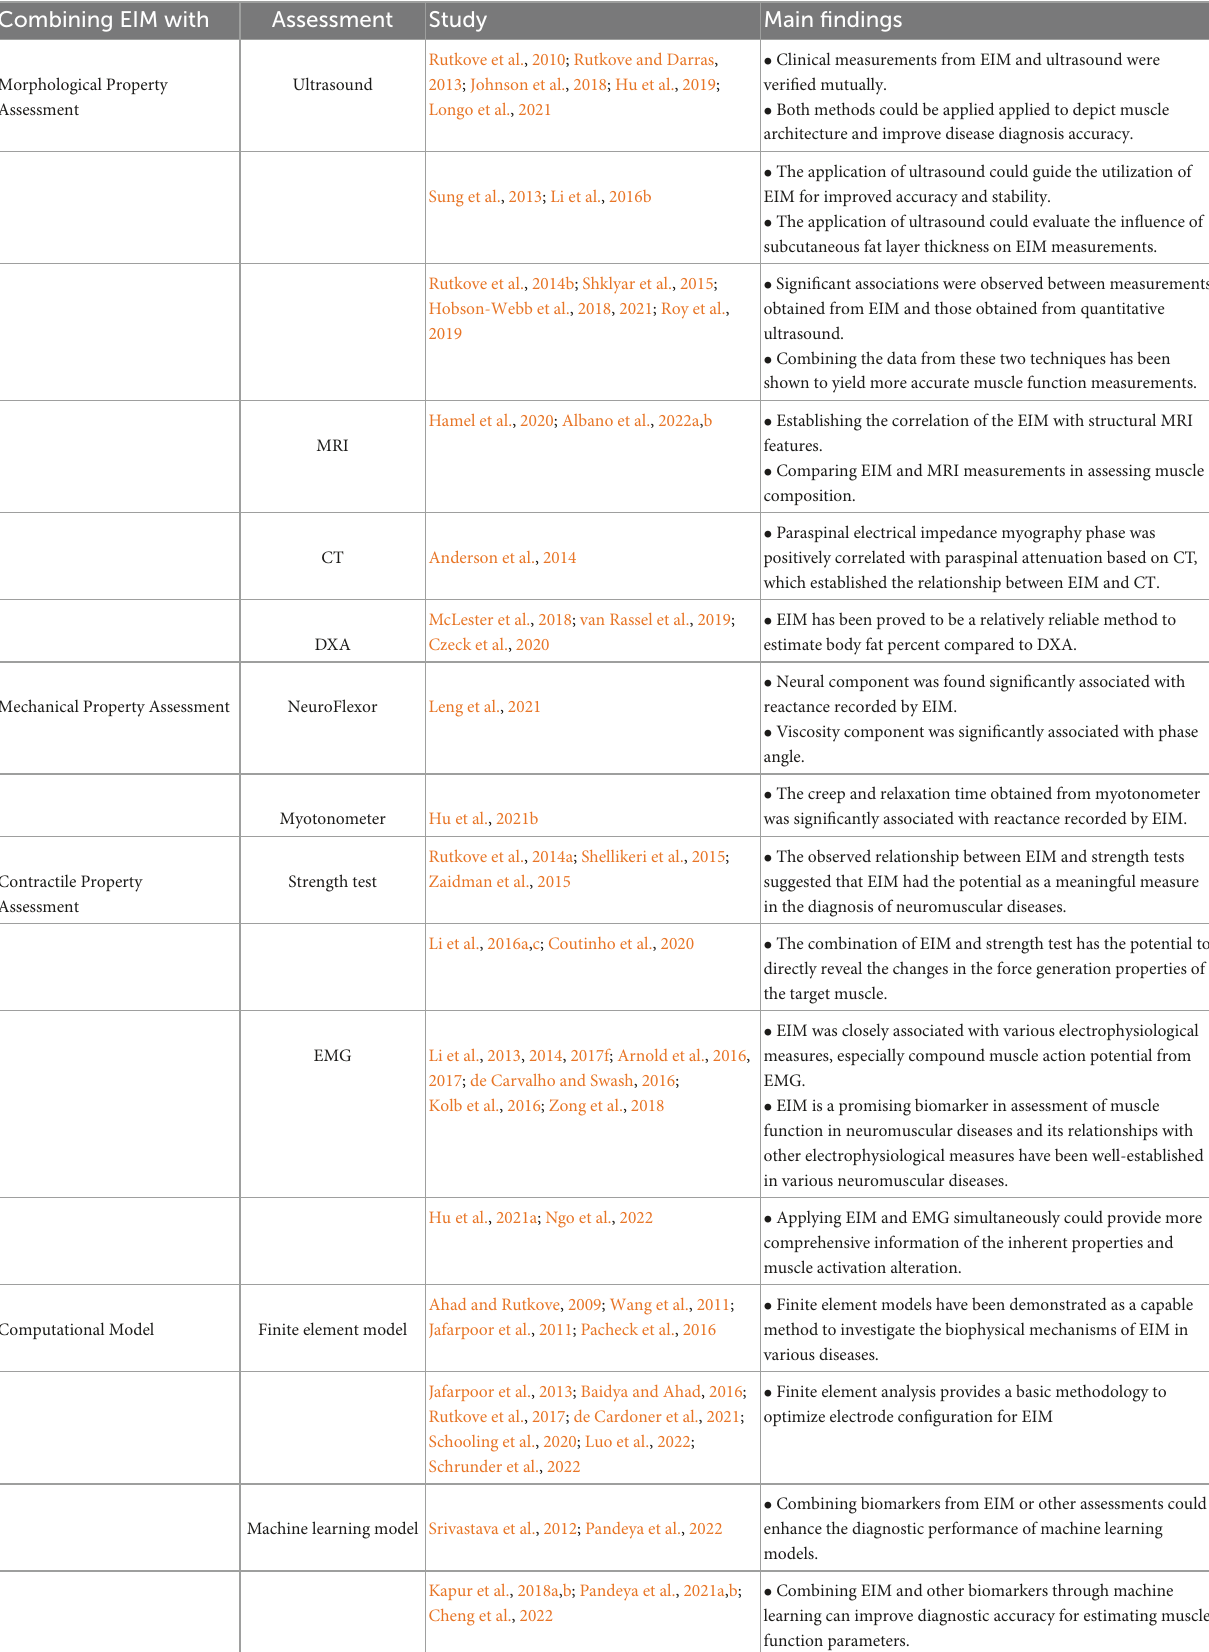
TABLE 1 The main findings of each